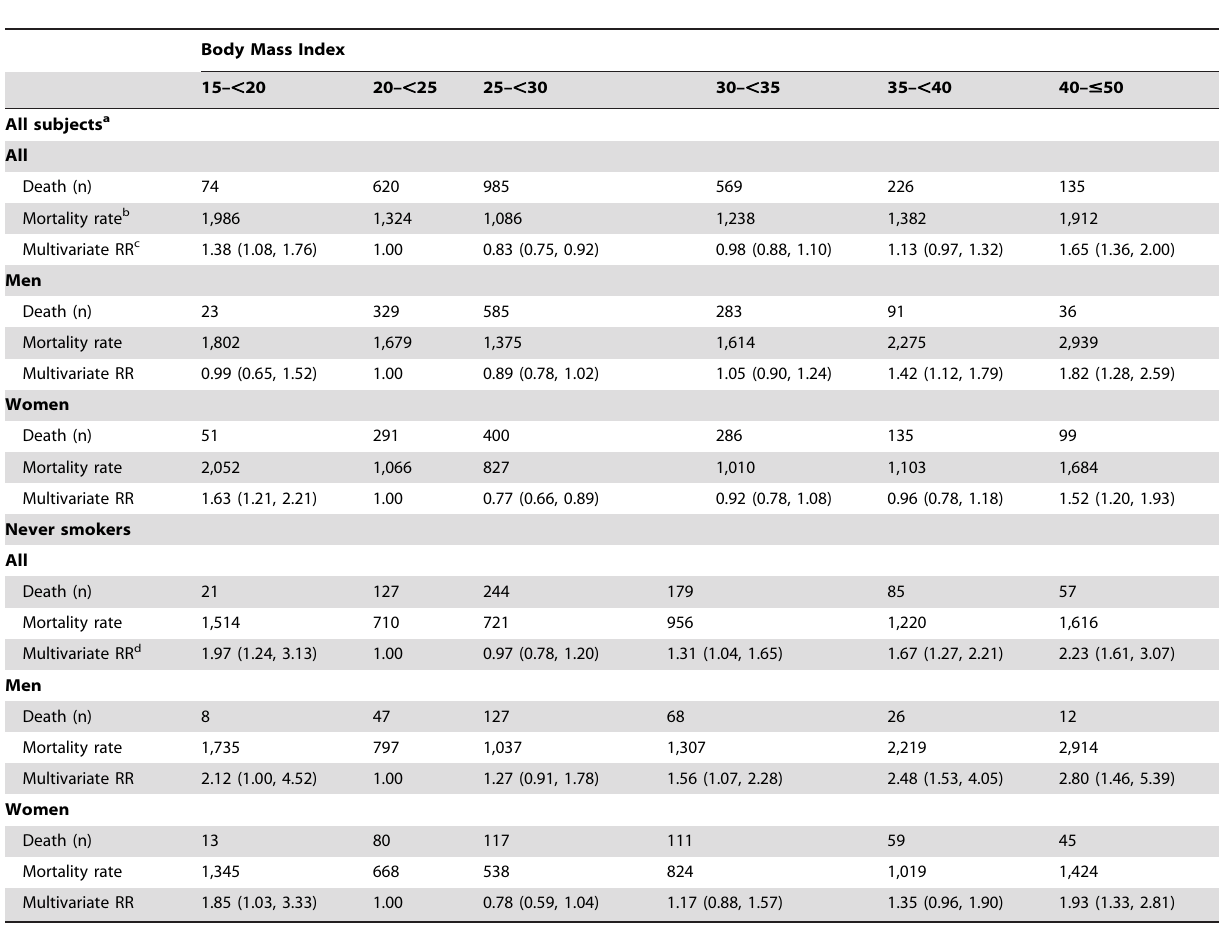
Table 2. Relative risks (RR) and 95% confidence intervals for total mortality by categories of body mass index in non-Hispanic